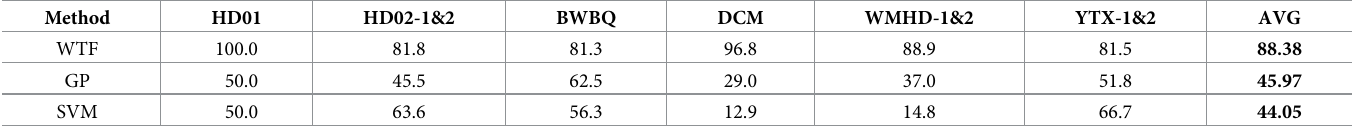
ments show that the gain in the Rank-1 recognition is less than 1% on the CASIA-B and 2% on the PKU on average. This validates that better view angle estimation does help for better gait recognition though the gain is not significant. There are two possible reasons. First, our view angle estimation is based on the analysis of pedestrian’s walking trajectory that can guarantee differences between the estimated angles. If wrongly estimated, the corresponding ground- truth (or its mirroring view angle in CASIA-B) should be quite small. Second, if the wrongly- estimated view angle is close to the corresponding ground-truth or its mirroring view angle, the VAM can learn an optimal manifold for gait similarity evaluation. Joint gait manifold. The joint gait manifold (JGM) evaluate the gait similarity between the probe and relevant gallery data by using the optimal joint manifold that is constructed . Similar to the discrete view transformation [20], two baseline methods were benchmarked: θ i VTM that transforms the gait features to y (denoted as R-VTM). To test whether more than j 2 Table 3. View estimation results (%) for each camera on the PKU database.